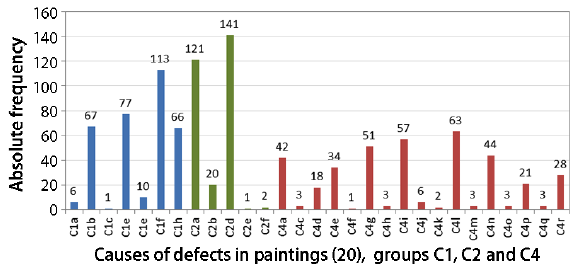
Fig. 21. Absolute frequency of the specific causes of anomalies in paintings (20) belonging to general groups C2 C1, and